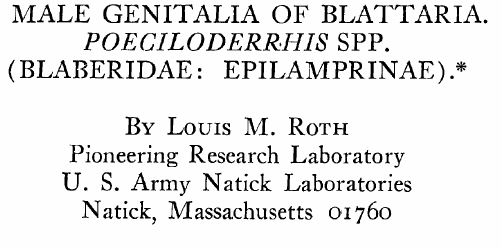
Figs. 1-9. 1-3. Epilampra maya Rehn. (158, USNM). Boston Quaran- tine (det. Roth). 4-9. Poeciloderrhis proxima. 4-6. (22, MCZ). Brazil (det. Roth). 7-9. (20, BMNH). Brazil, Rio de Janeiro, Itatiaya (det. Roth).